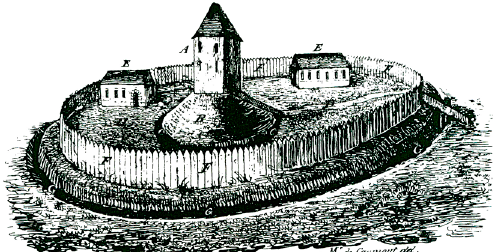
Figure 2. Motte-and-Bailey castle [14].